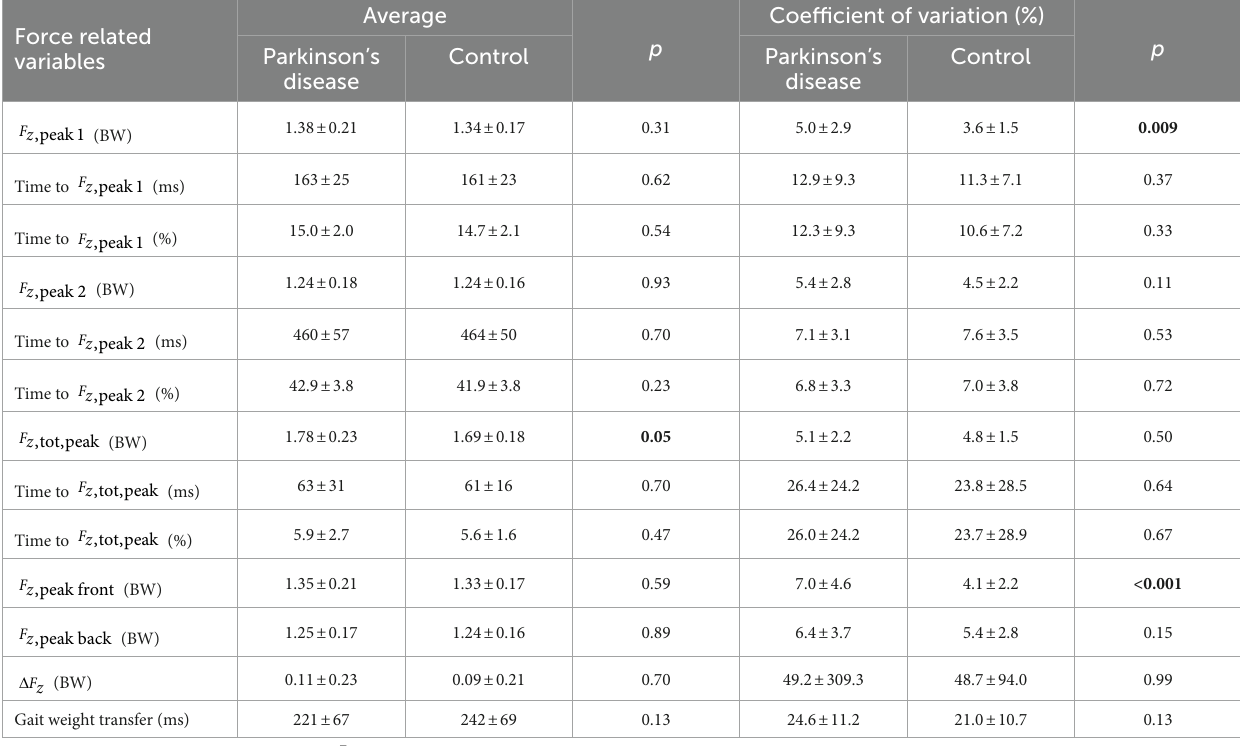
TABLE 4 Force related variables for Parkinson’s disease and control groups.